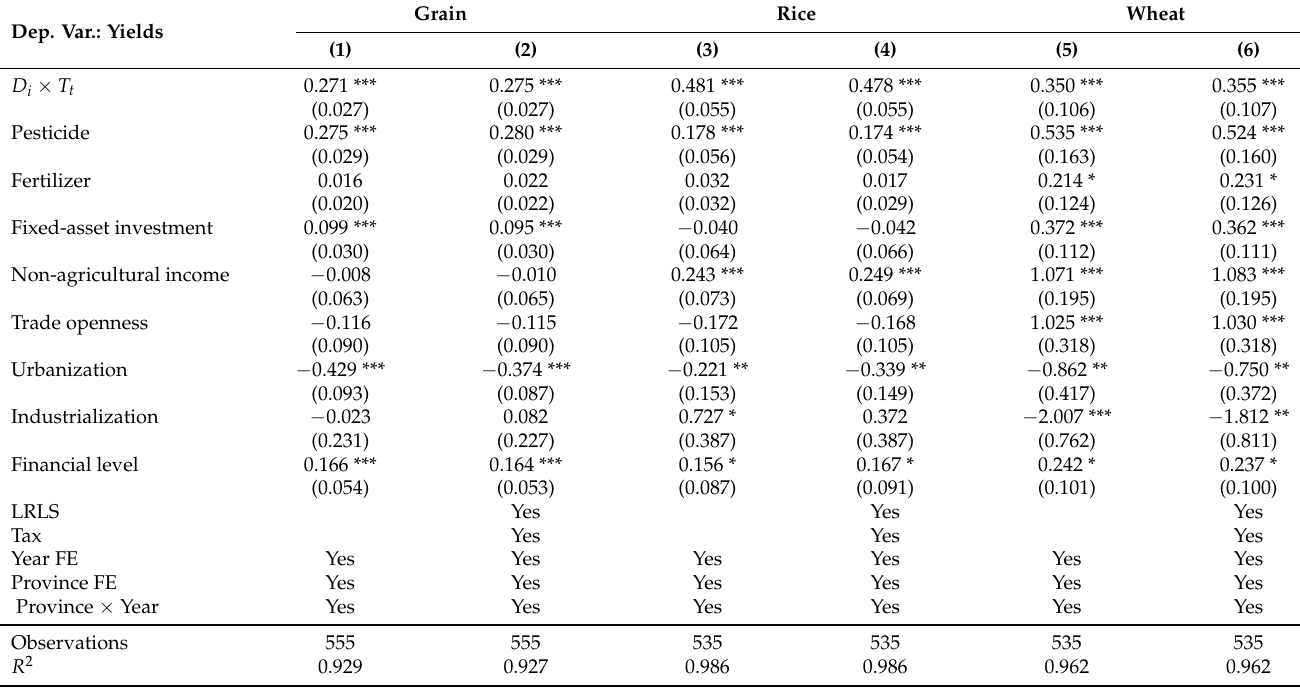
Table 6. The baseline DD estimation.